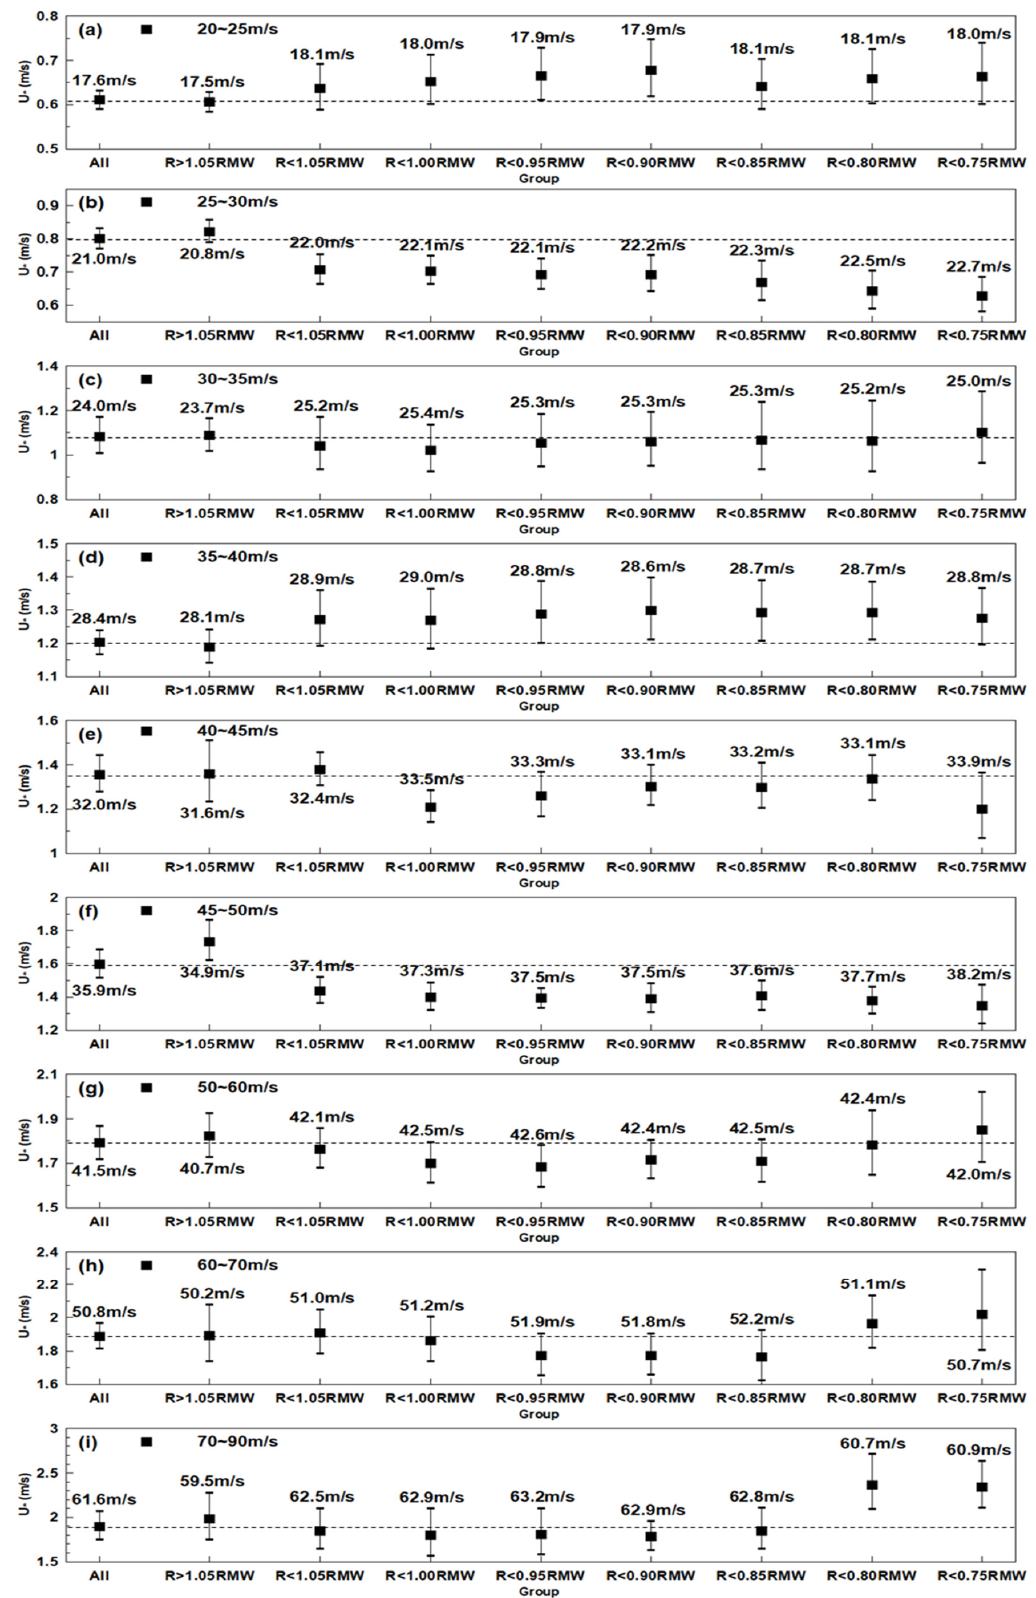
Figure 4. Friction velocity ( u ∗ , unit: m s − 1 ) at every wind speed bin from different R/RMW groups (including all data, and data with R > 1.05RMW, R < 1.05RMW, R < 1.00RMW, R < 0.95RMW, R <